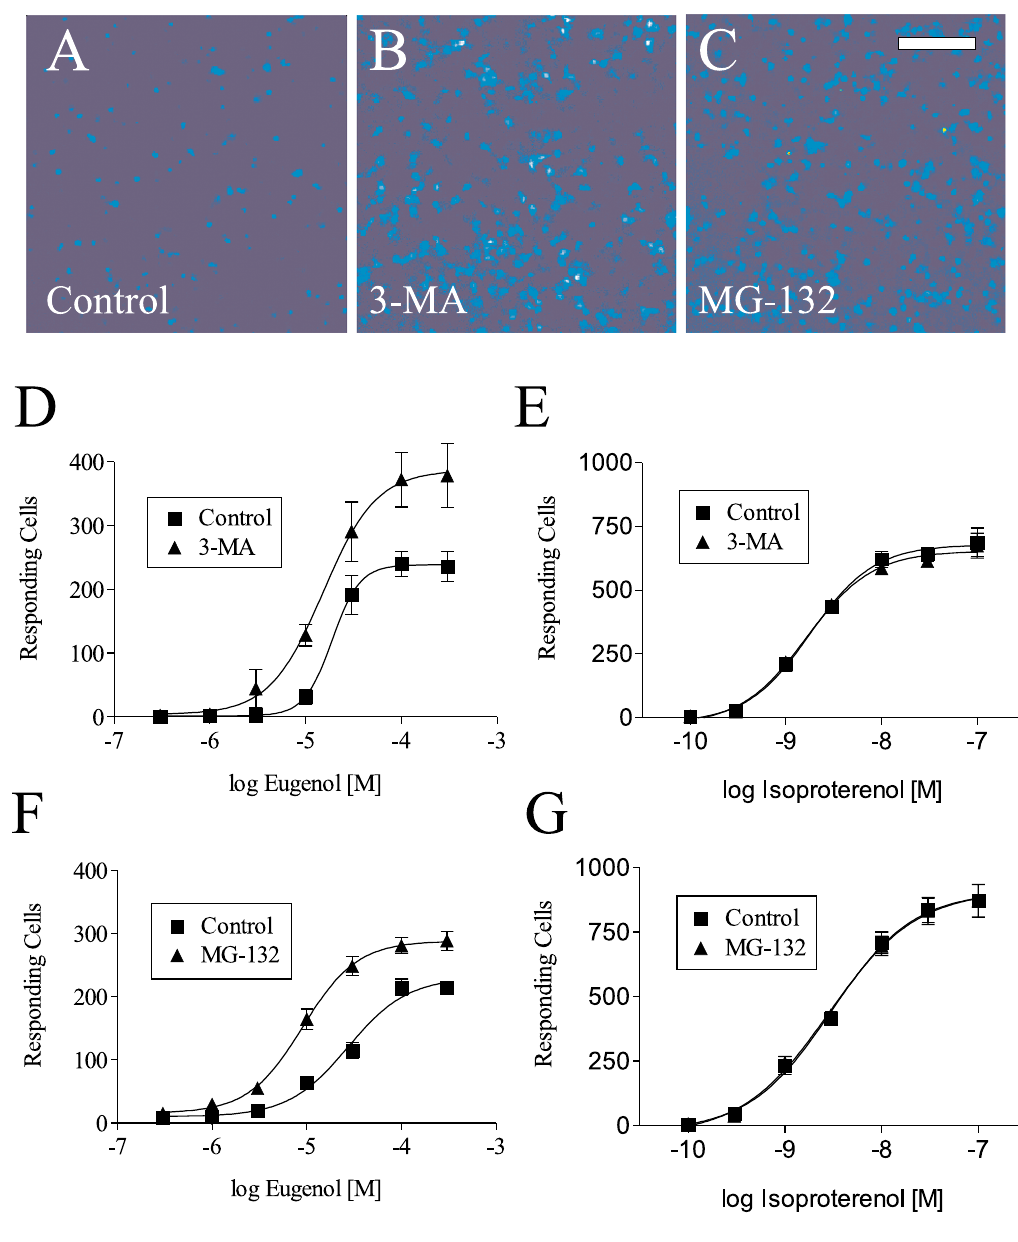
Figure 2 ER degradation limits Rho-mOREG functional expression. CNG cells transiently transfected with Rho-mOREG were assayed for increases in intracellular calcium in response to 10 uM eugenol following treatment with vehicle (control, 0.1% DMSO; A), 10 mM 3-MA (B) or 50 uM MG-132 (C) for 4 h. Images contain ~750–1000 confluent cells and represent responses 60 sec following odorant stimulation. Scale bar is 150 um. Dose-response curves were determined for eugenol (300 nM to 300 uM; D and F) or isoproterenol (100 pM to 100 nM; E and G) in cells treated with vehicle (control), 10 mM 3-MA (D and E) or 50 uM MG-132 (F and G) for 4 h. ~20–25% of total cells or ~40–50% of transfected cells (~50% transfection efficiency) responded to 100 uM eugenol under control conditions. Note that degradation inhibitors specifically increased Rho-mOREG functional responses and had no effect on β -AR function. The EC value for eugenol was larger for control (17.1 +/- 3.0 uM) 50 compared to 3-MA (10.8 +/- 2.6 uM) and MG-132 (8.1 +/- 2.6 uM) treatments, but these differences did not achieve statistical significance. The EC values for isoproterenol for control (3.7 +/- 1.0 nM), 3-MA (4.2 +/- 2.5 nM), and MG-132 (2.6 +/- 0.9 nM) 50 treatments were not significantly